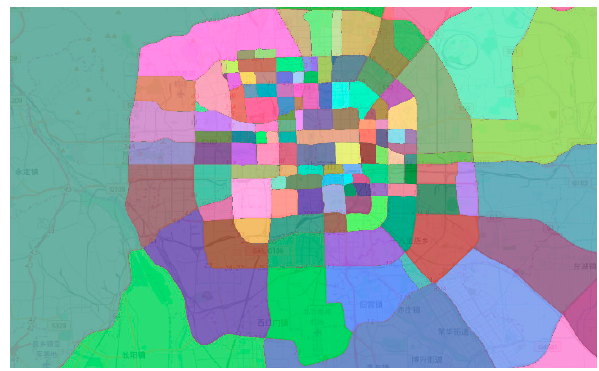
Figure 2. Zoning result by main roads in Beijing.